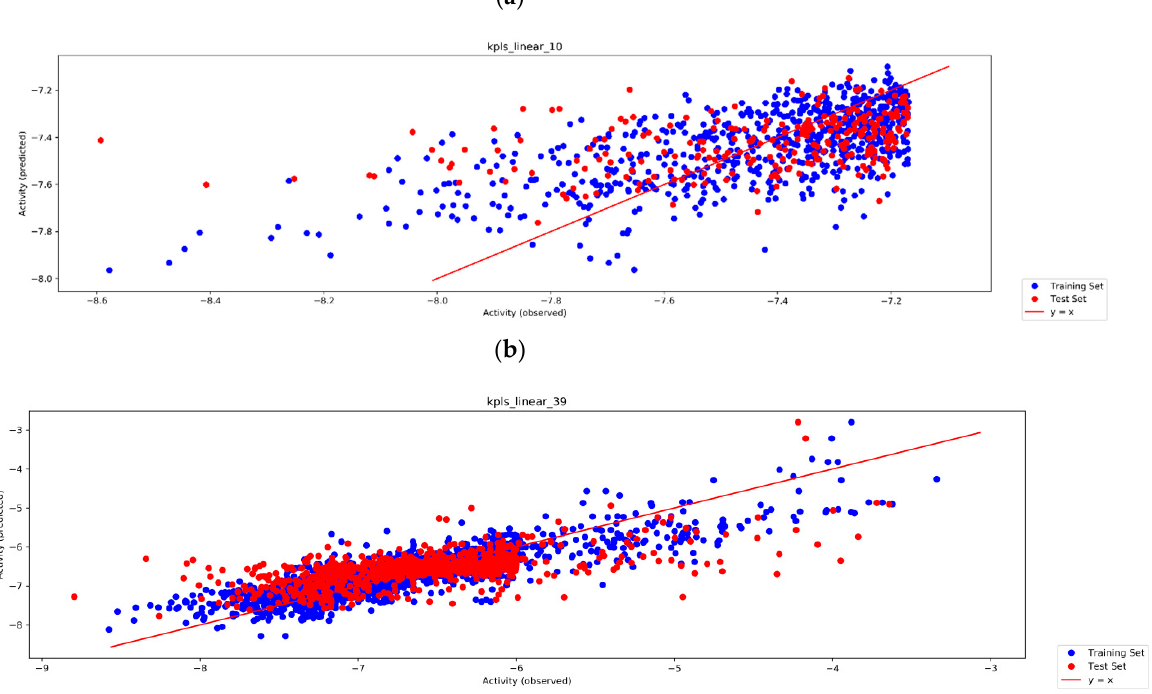
Figure 3. Auto QSAR active learning plots for model 8 ( a ) with an R 2 of 0.7579 and a Q 2 of 0.7191 and model 10 ( b ) with an R 2 of 0.7410 and a Q 2 of